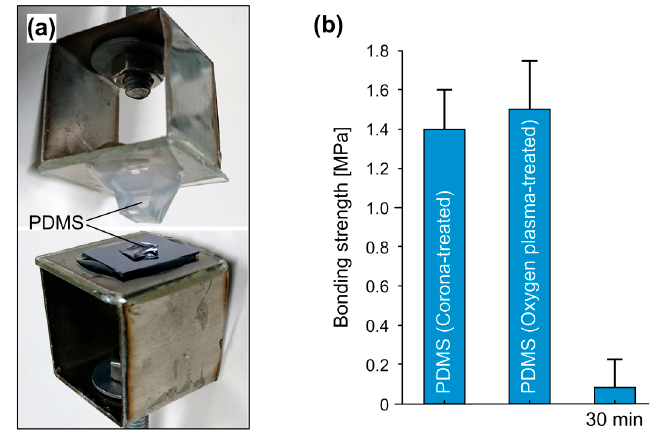
Figure 5. Tensile strength test for the PDMS-SU-8 bonding. ( a ) Photo of a broken sample after the tensile test; ( b ) bonding strength of samples treated under different conditions: corona-activated PDMS, oxygen plasma-activated PDMS and 30-min-aged PDMS and SU-8 after APTES silanization. Error bars represent the standard deviation of seven measured samples under each condition.